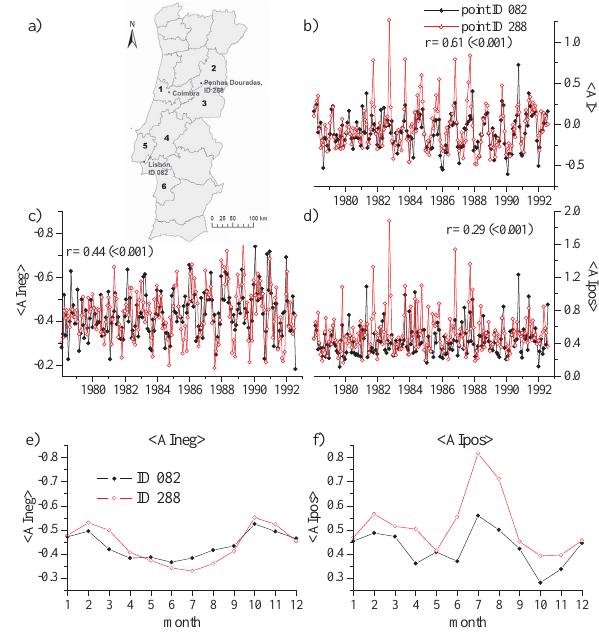
Figure 1. (a) Map of continental Portugal with the locations of the satellite AI observation points (ID 082 and ID 288) and the meteoro- logical stations (Coimbra, Lisbon and Penhas Douradas). Districts used for calculation of the wildfire burned area: 1 – Coimbra, 2 – Guarda, 3 – Castelo Branco, 4 – Santarém, 5 – Lisboa, 6 – Setúbal. (b – d) Monthly mean (cid:104) AI (cid:105) (b) , (cid:104) AIneg (cid:105) (c) and (cid:104) AIpos (cid:105) (d) series for two satellite locations: ID 082 and ID 288. (e – f) Annual cycle of (cid:104) AIneg (cid:105) (e) and (cid:104) AIpos (cid:105) (f) for the sites ID 082 and ID 288 for the time period 1979–1992. Please note the inverted y axes in (c) and (e) . Correlation coefficients r for the AI series from different sites are shown with p values in